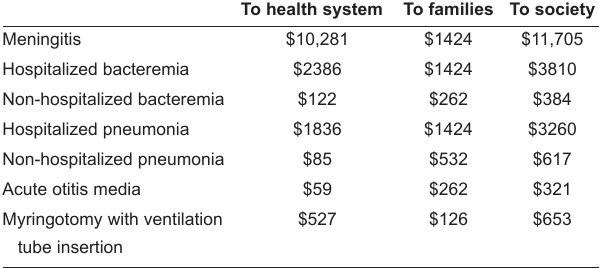
TABLE 2 Unitary costs* of pneumococcal-related outcomes in Canada To health system To families To society